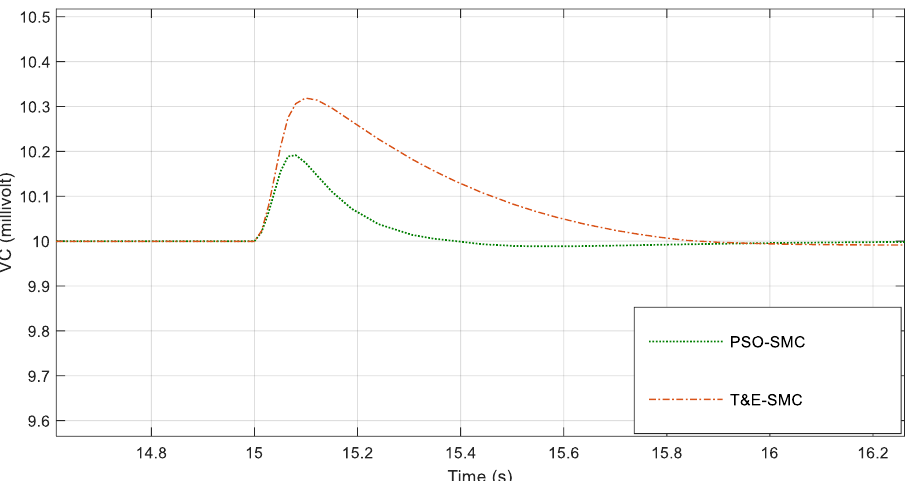
Figure 8. Magnification of Figure 5 around the tenth second.